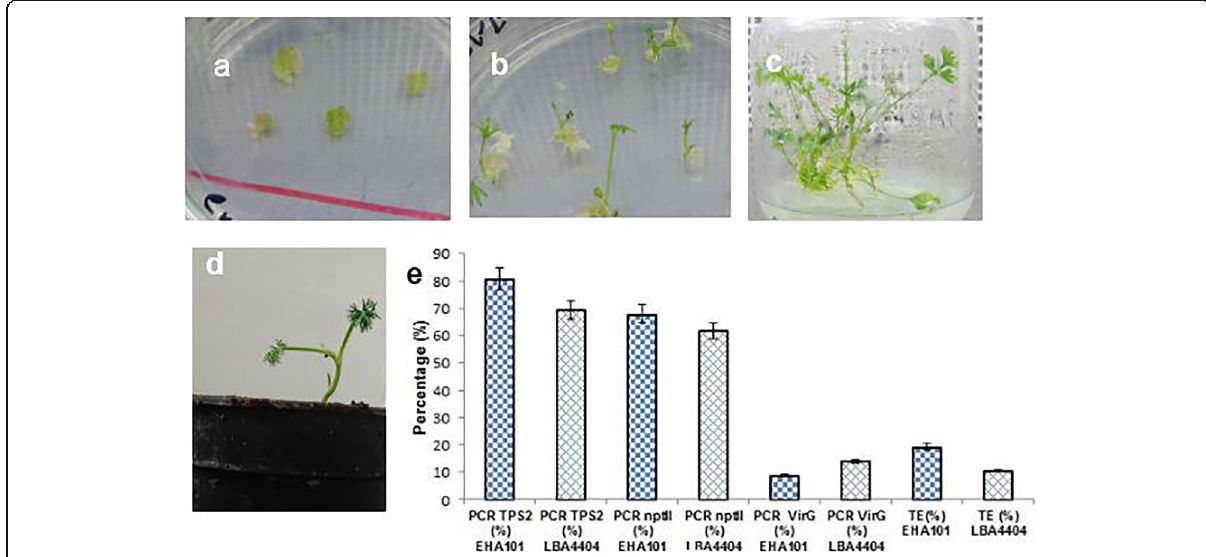
Fig. 5 Agrobacterium -mediated transformation of Trachyspermum ammi . a Callus induction in selective media containing kanamycin and cefotaxime from zygotic embryos. b Development of shoot and root. c Putative transgenic plant. d Acclimatized transgenic plant in the pot. e Percentage of PCR results of transformed T. ammi , and TE: transformation